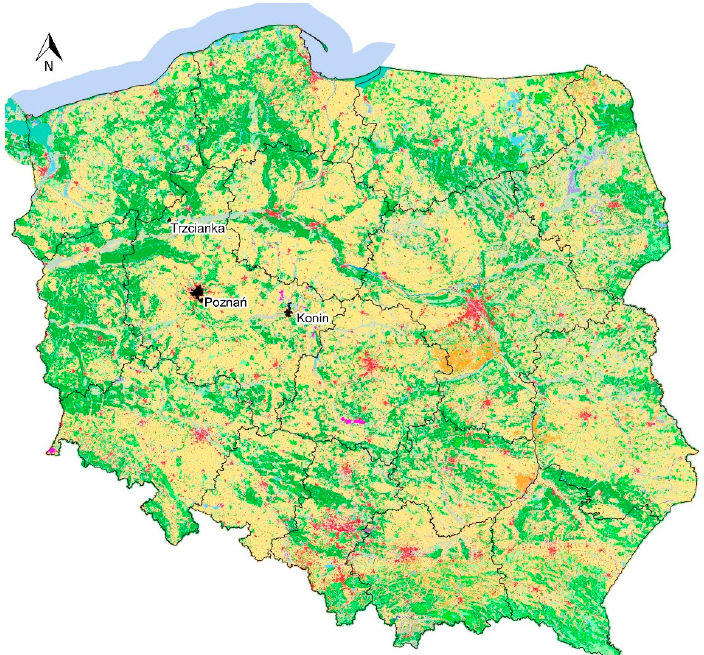
Figure 1. Location of cities included in the analysis.